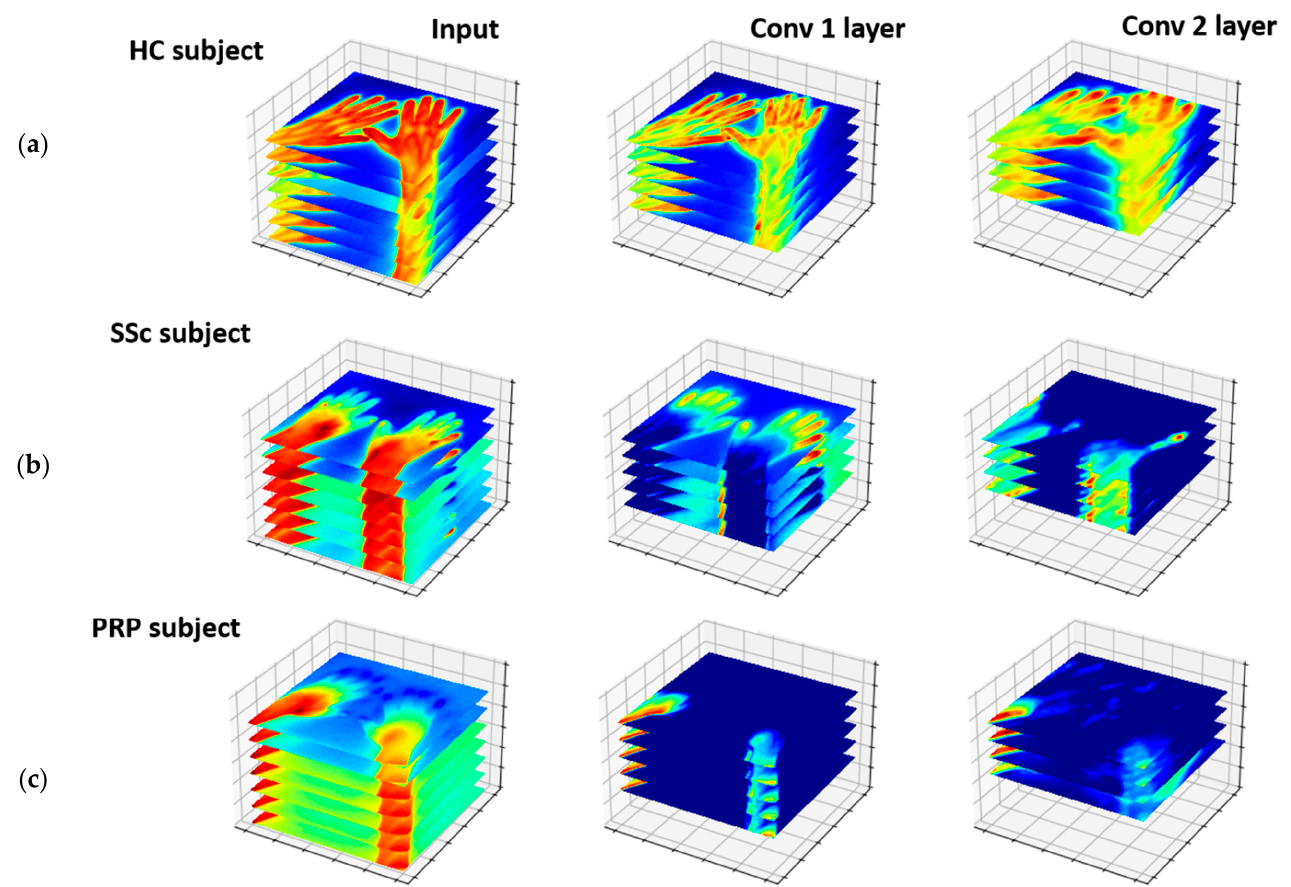
Figure 5. 3-Dimensional Deep Convolutional Neural Network (3D-DCNN) feature maps. ( a ) Batch of input images representative of the cold challenges procedure (CCP) data of a healthy participant randomly chosen, together with the features map resulting from the first two 3D-convolutional layers. ( b ) Batch of input images of a systemic sclerosis (SSc) participant randomly chosen, and the related features map resulting from the first two 3D-convolutional layers. ( c ) Batch of input images of a primary Raynaud’s phenomenon (PRP) participant randomly chosen, and the related features map resulting from the first two 3D-convolutional layers.